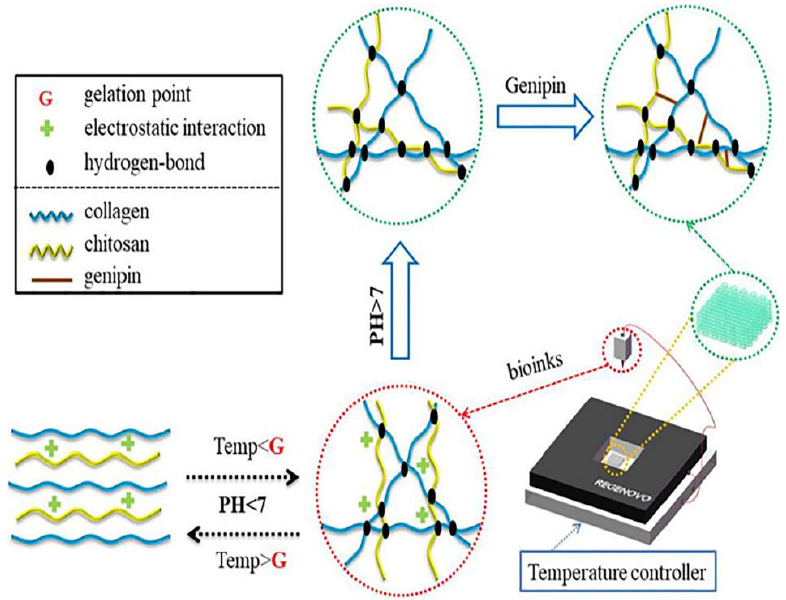
Figure 14. Schematic diagram of 3D printing Col/Chi scaffold. Reprinted from [48], Copyright 2021, Elsevier.